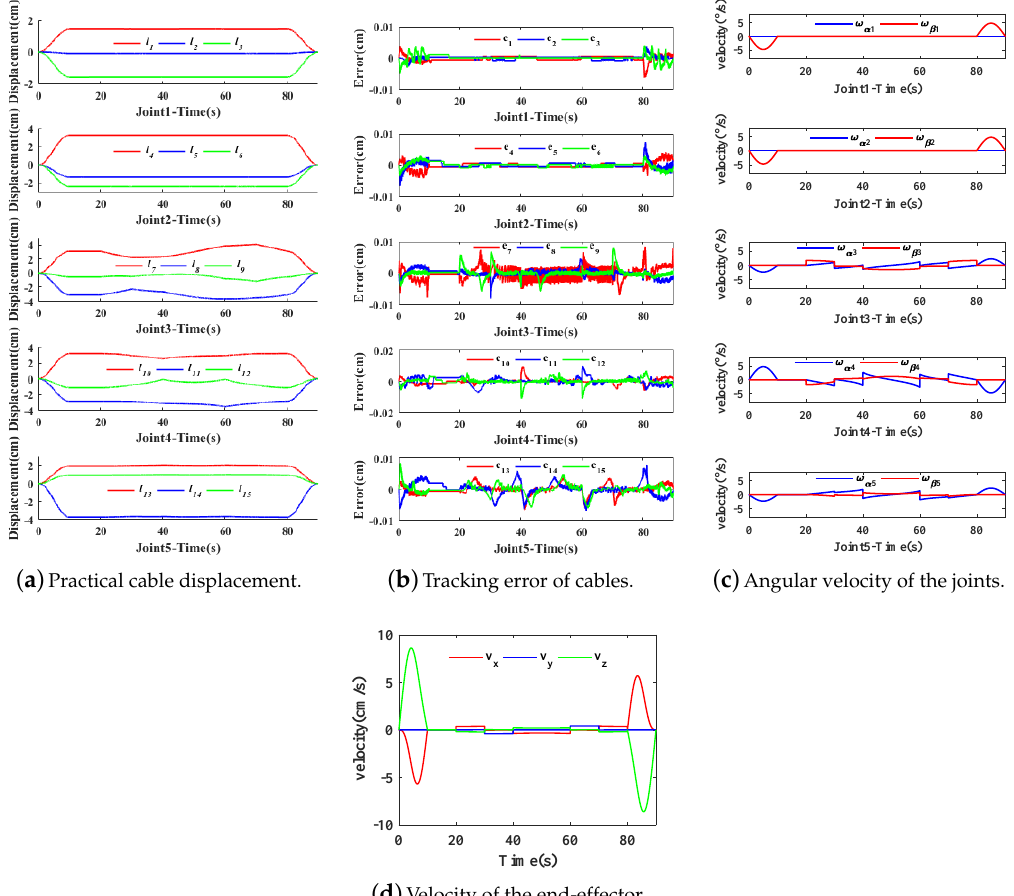
Figure 12. Experiment result of SET1 in the underwater environment.